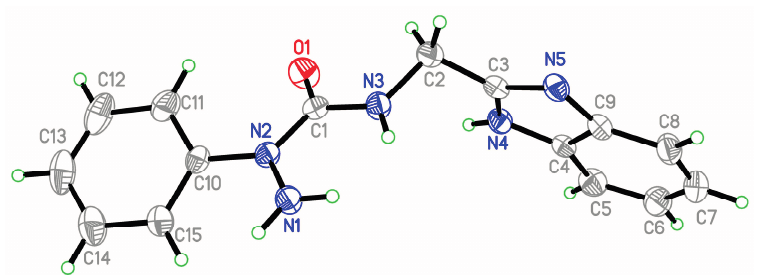
Figure 1. ORTEP drawing of 2-phenyl-4-[(1 H -benzo[ d ]imidazol-2-yl)methyl]semicarbazide ( 8a ).